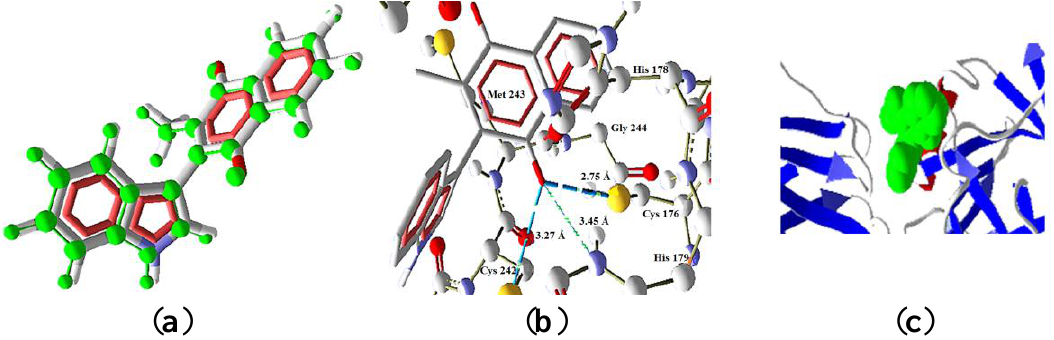
Figure 10 . Interaction of 4 with p53. ( a ) 4 overlapping of the ligand (red) and the pose (grey). ( b ) Interaction of 4 and p53 (PDB code 2OCJ) complex, three H bonds with protein residues. ( c ) Secondary structure, ligand (green) in the middle of the two monomers.